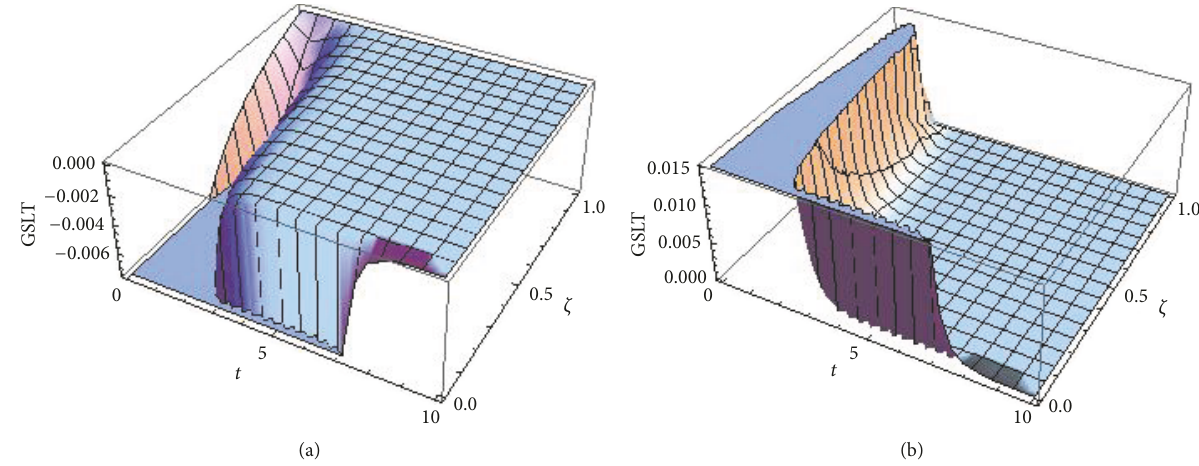
Figure 3: Validity of GSLT for the model (45). (a) is for 𝑐 1 = 𝑐 2 = 1 and (b) for 𝑐 1 = 1 with 𝑐 2 = −1 .